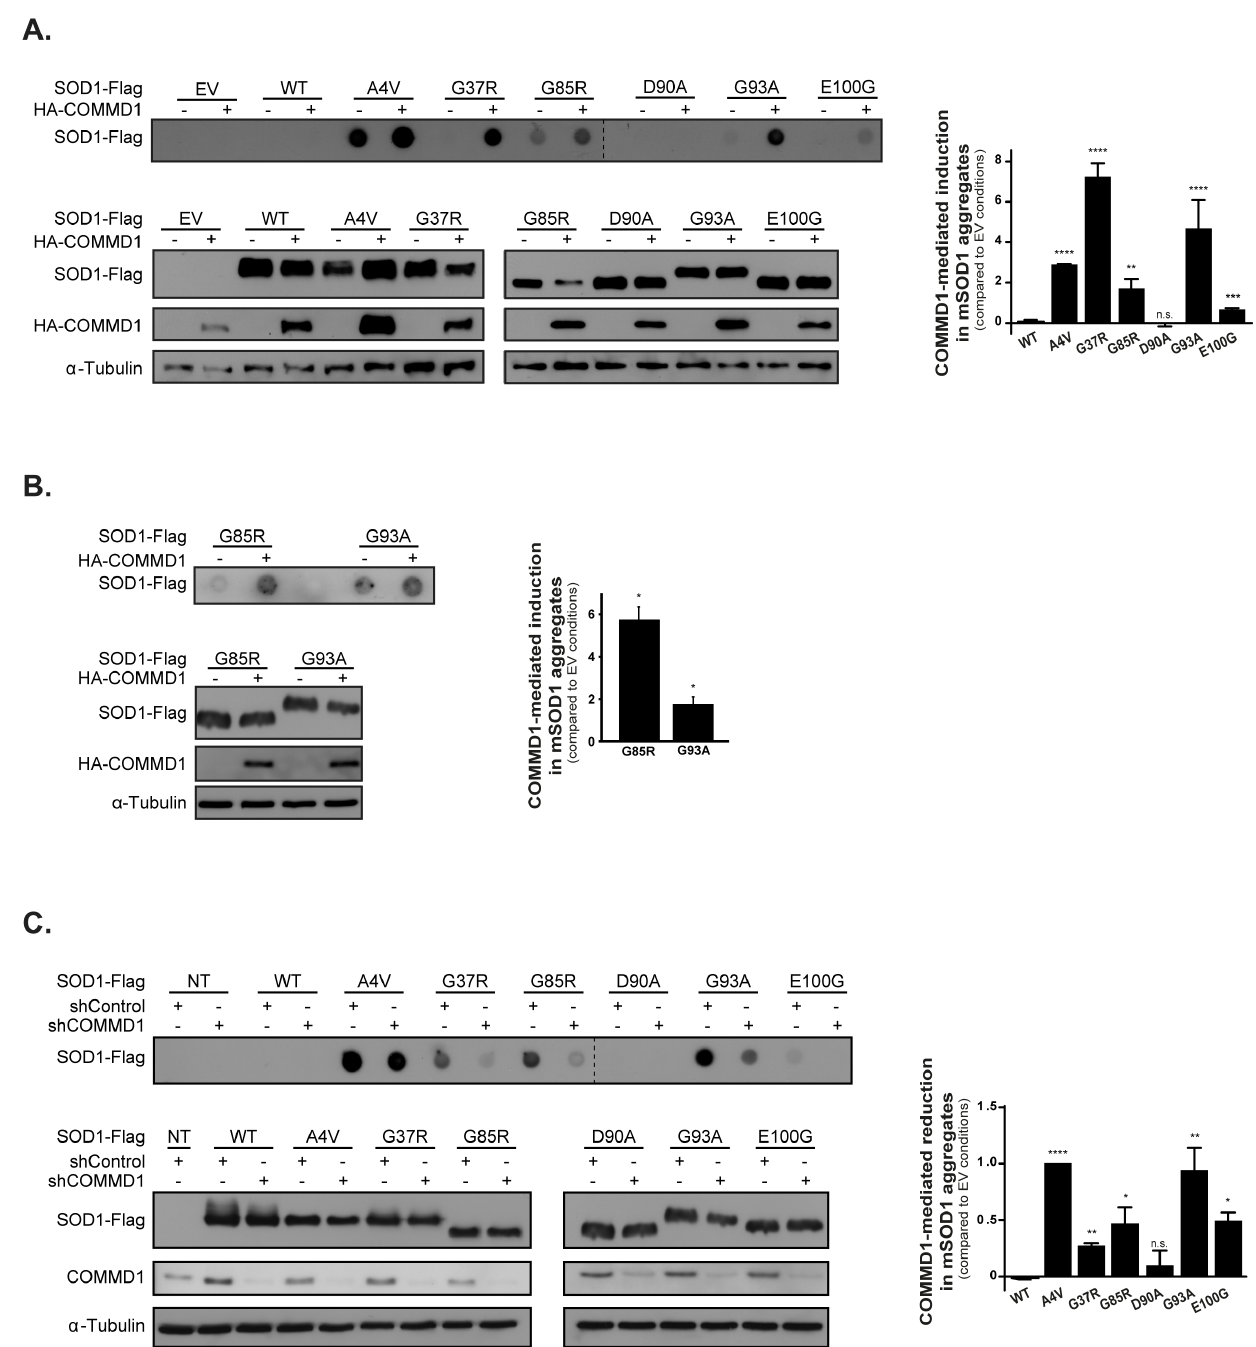
Figure 2. COMMD1 mediates aggregation of ALS-associated SOD1 mutants. A. SOD1-Flag WT and mutant (A4V, G37R, G85R, D90A, G93A, E100G) constructs were co-transfected with either EV (–) or HA-COMMD1 in HEK293T cells prior to detection of SOD1 aggregates by means of filter trap analysis on cellulose acetate membrane as described in Experimental procedures section (40 m g protein; upper panel). Aggregates were analysed on the same membranes and visualized by IB using antibodies directed against the Flag-tag. Input samples (15 m g protein; lower panel), corresponding to the filter trap analysis, represent total cell lysates of each condition, and were visualized using antibodies directed against the Flag- and HA-tag, and a -Tubulin, respectively. Input samples were analysed on separated membranes. Graph represents the relative COMMD1-mediated induction in SOD1 aggregates compared to EV conditions (representative for at least 3 independent experiments). EV, SOD1 WT and mSOD1 D90A values were considered as 0 as these proteins do not form aggregates. * indicates significantly increase in mSOD1 aggregation mediated by COMMD1 (** p , 0.005, *** p , 0.001, **** p , 0.0001). n.s. = non-significant. B. Filter trap analysis of Neuro2A cells transiently transfected with SOD1- Flag mutants G85R and G93A in combination with either EV (–) or HA-COMMD1. Detection of aggregates and input samples was performed as described in Figure 2A. Graph represents the relative COMMD1-mediated induction in mSOD1 aggregates compared to EV conditions (representative for at least 3 independent experiments). * indicates significantly increase in mSOD1 aggregation mediated by COMMD1 (* p , 0.05). C. Filter trap analysis performed in HEK293T cells stably transfected with shControl or shCOMMD1 and co-transfected with SOD1-Flag WT and mutants (A4V, G37R, G85R, D90A, G93A, E100G). Aggregates were analysed on the same membranes. Analyses were performed as described in Figure 2A. Input samples